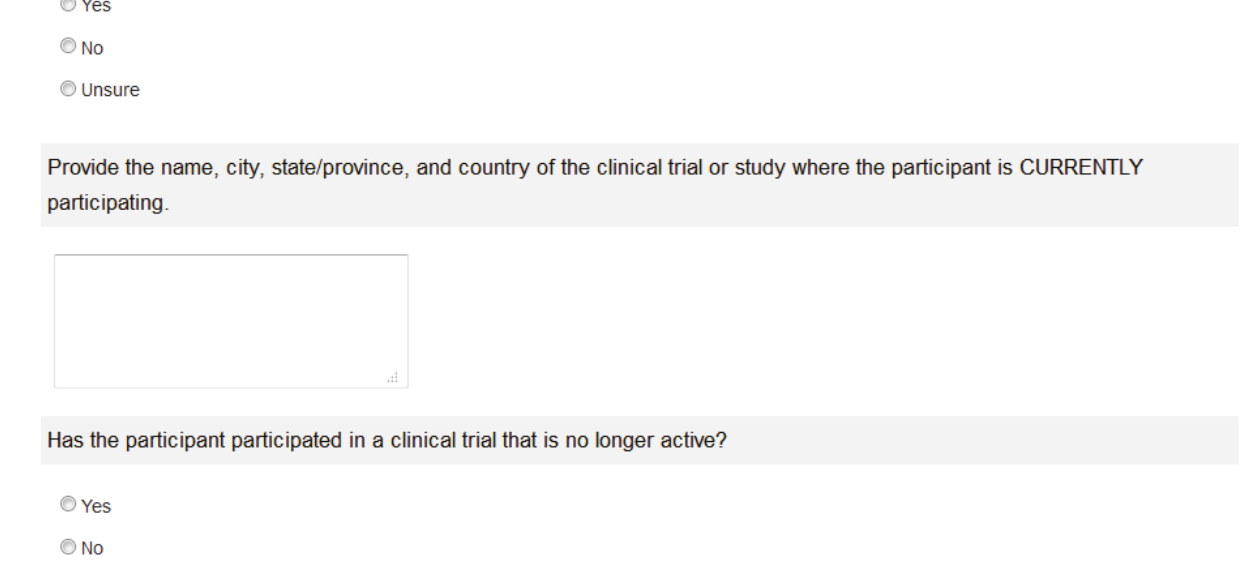
Supplemental Figure 8. Clinical